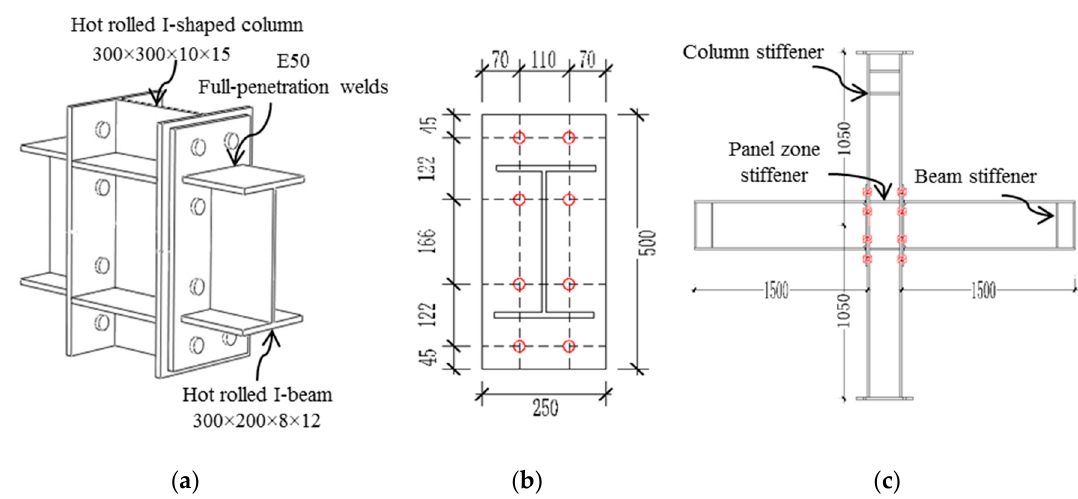
Figure 2. Details of joint specimens. (mm): ( a ) Detail drawing of the connection; ( b ) Layout of the end-plate and bolts; ( c ) Overall size of the intermediate column joints. Table 1. Configuration details of joint specimens.